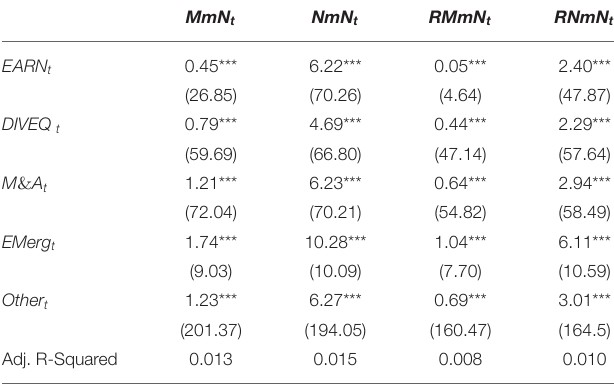
TABLE 5 | Events that drive the coverage of news.